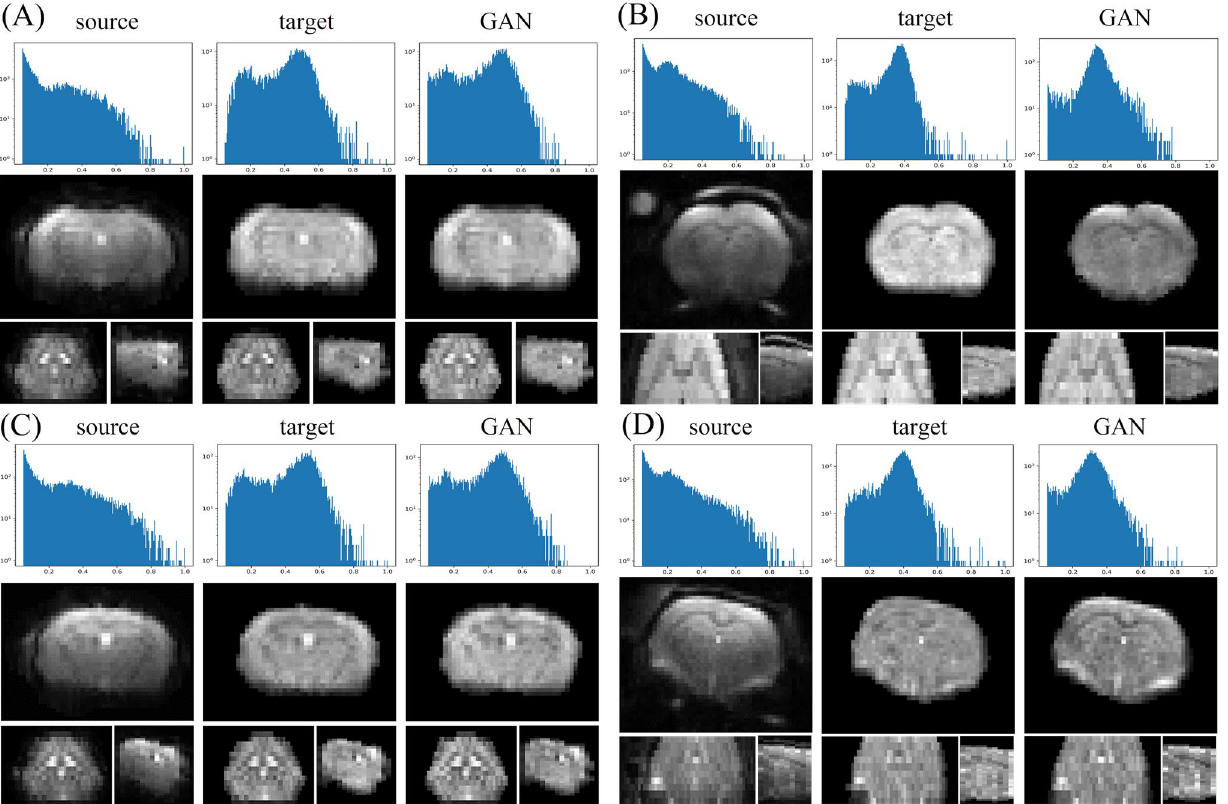
Figure 3. Example results of 3 experiments. From left to right are the histograms and tri-planar views of the source, target and GAN output images from the ( A ) GE-EPI-only model, ( B ) SE-EPI-only model, and ( C , D ) mixed model. ( A ) and ( C ) show the GE-EPI images, and ( B ) and ( D ) are the SE-EPI images.